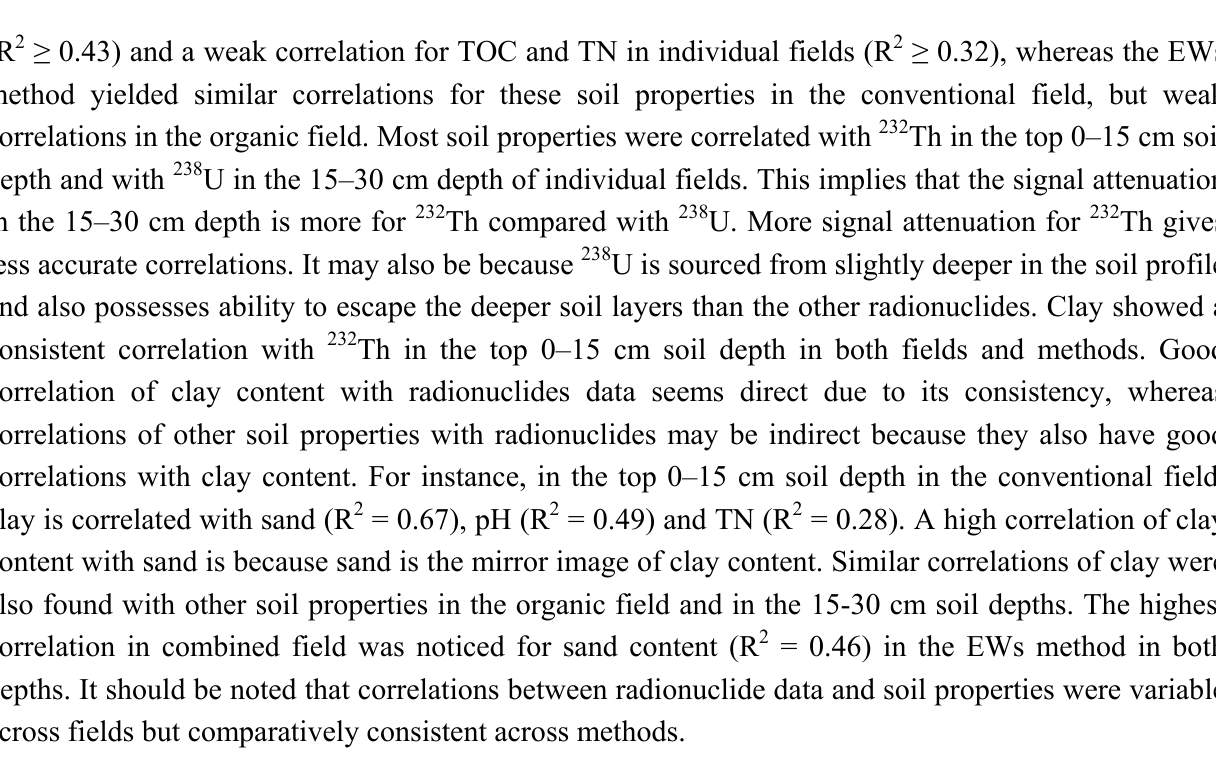
Table 5. Calibration statistics for individual as well as combined